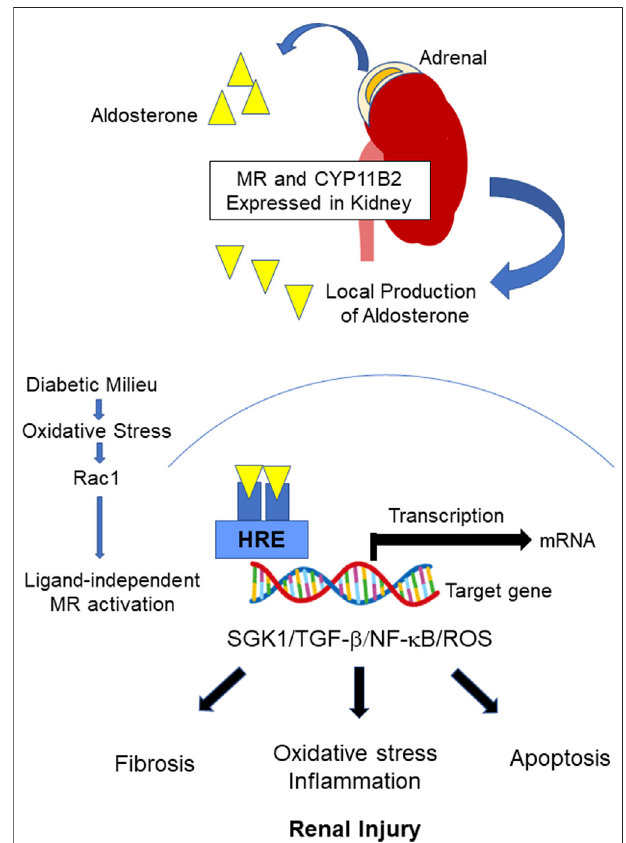
FIGURE 1 | Regulation of MR in DKD. Upon the binding of aldosterone to MR, the bound MR translocates into the nucleus and binds to the HRE of the target gene to initiate transcription. CYP11B2 is expressed in the kidney, and local aldosterone production occurs in DKD, leading to MR overactivation. MR overactivation stimulates SGK1 and induces subsequent in fl ammation/oxidative stress, apoptosis, and fi brotic process. Furthermore, ligand-independent MR activation by Rac1 has been reported. MR: mineralocorticoid receptor, DKD: diabetic kidney disease, HRE: Hormone responsive element, SGK1: Serum and glucocorticoid-regulated kinase 1, TGF- β : transforming growth factor beta, NF- κ B: Nuclear factor κ B, ROS: reactiveoxygenspecies,Rac1:Thesmallguanosinetriphosphatase(GTPase) RAS-related C3 botulinus toxin substrate